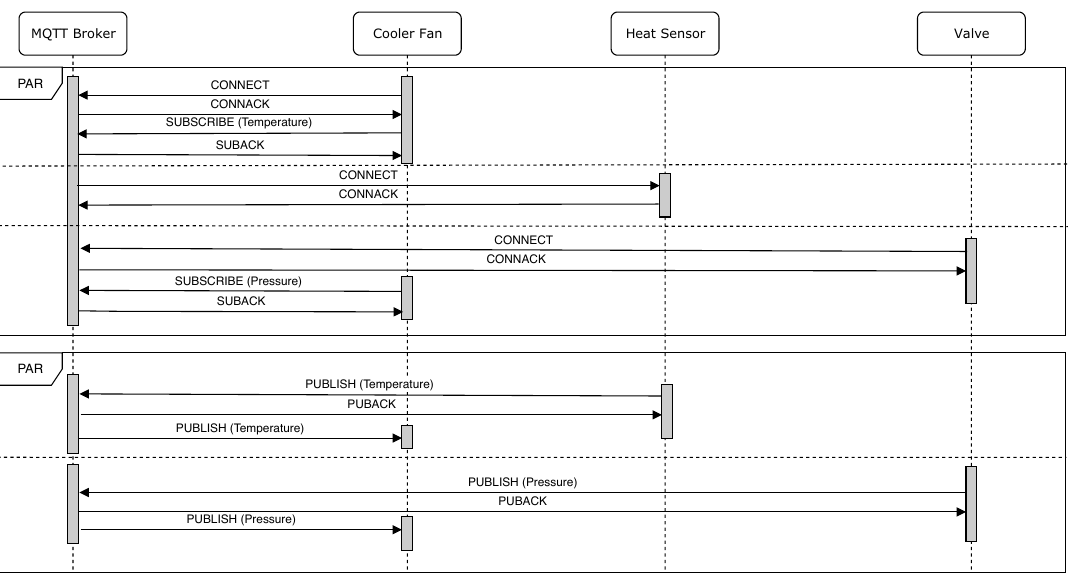
Figure 2. An example of a simplified heating, ventilation, and air conditioning (HVAC) system’s message passing using MQTT protocol.